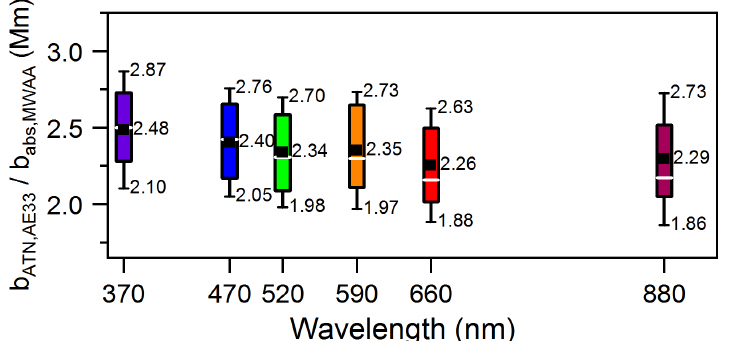
Figure A1. Wavelength-specific AE33 calibration coefficients, C(λ) , upon comparison of the loading-compensated AE33 attenuation with the MWAA absorption coefficient; Sects. 2.1.3; S3.1) for 27 quartz fibre filter samples from Magadino 2013 (PM 10 ), Magadino 2014 and Zurich 2013 (PM 2 . 5 ) (white line and box: median and IQR; black squares and whiskers: mean and 1 SD (labels)).